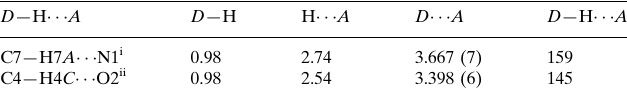
Hydrogen-bond geometry (A˚ , (cid:1)